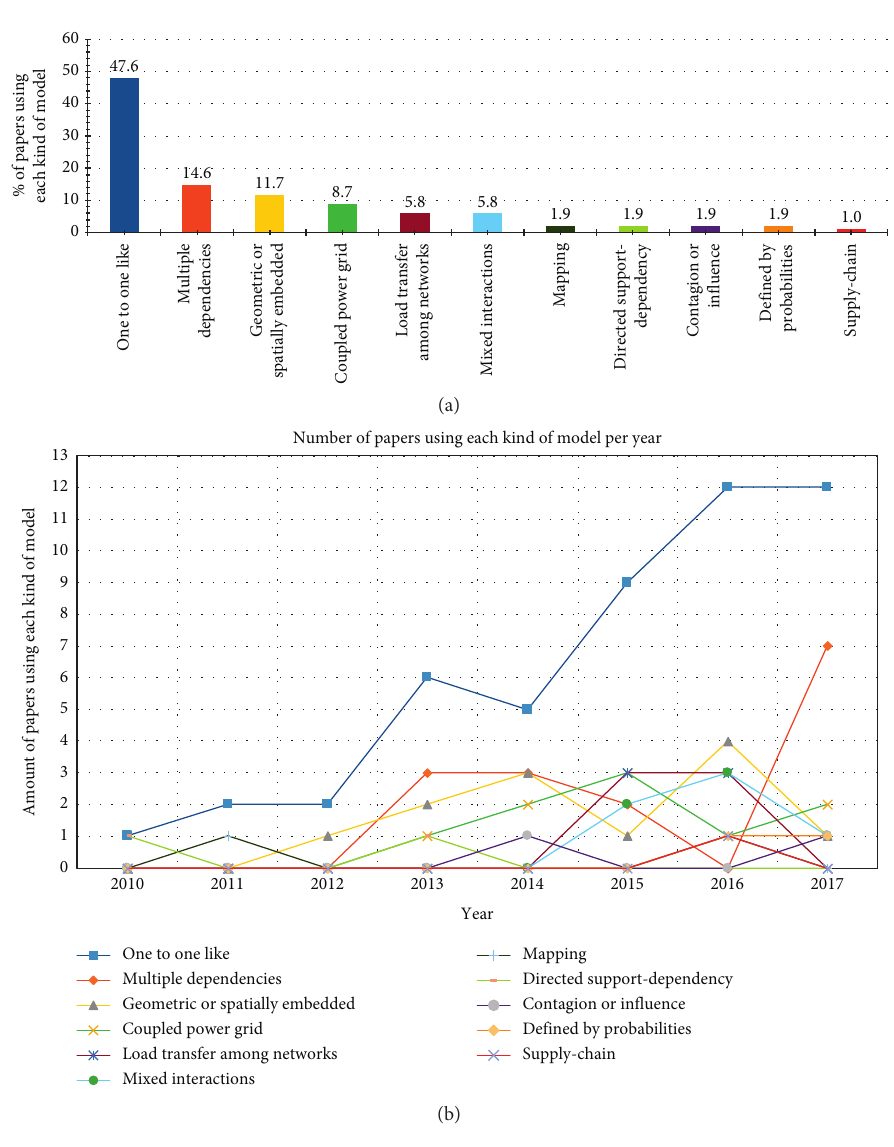
Figure 2: Model usage among the articles reviewed. (a) Percentage of papers using each type of model. (b) Amount of papers per year using each type of